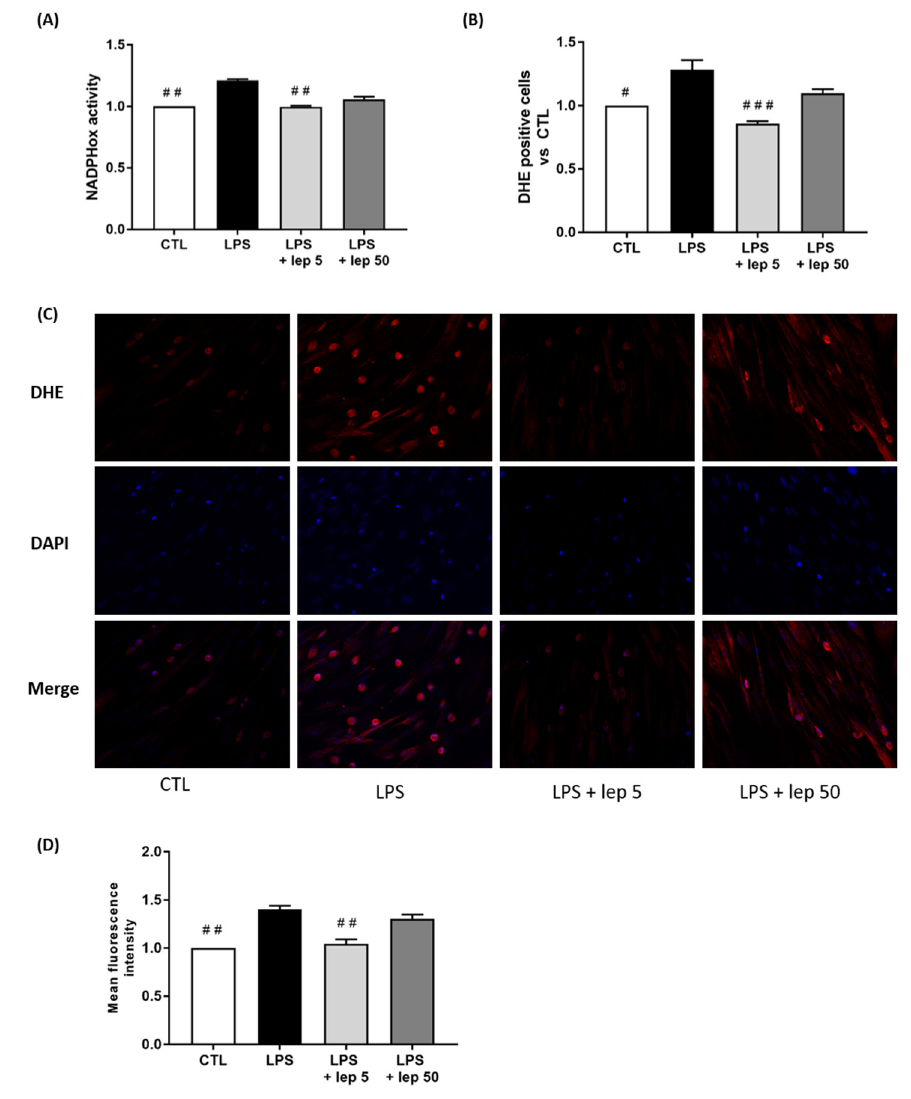
Figure 3. Effect of leptin on ROS production in co-cultured cells. Myocytes and macrophages were co-cultured and treated with LPS and leptin at 5 or 50 ng/mL. ( A ) NADPHox activity measured by luminometric analysis and related to the protein levels. Relative values versus CTL are represented as mean ± SEM, n = 4, ## p < 0.01 versus LPS. ( B ) Proportions of DHE-positive cells represented as fold induction versus CTL (mean ± SEM), n = 4, # p < 0.05 and ### p < 0.001 versus LPS. ( C ) Fluorescence images of DHE (red) and DAPI (blue) staining, taken with an epifluorescence microscope at ×200 magnification in randomly selected fields, representative of five pictures taken for each condition, n = 5. ( D ) Mean fluorescent intensity of DHE staining represented as fold induction versus CTL (mean ± SEM), n = 5, ## p < 0.01 versus LPS.